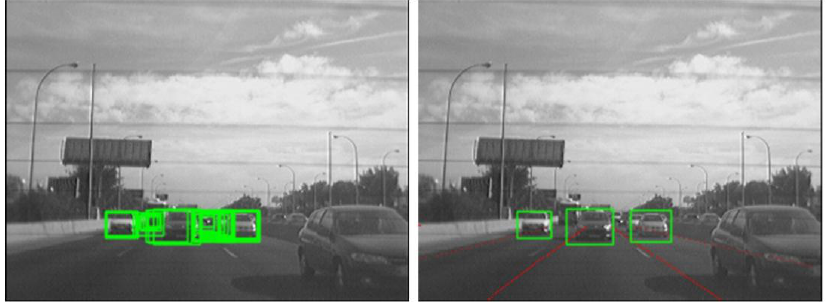
Figure 9. Left: overlapped candidates. Right: non-maximum suppression results.